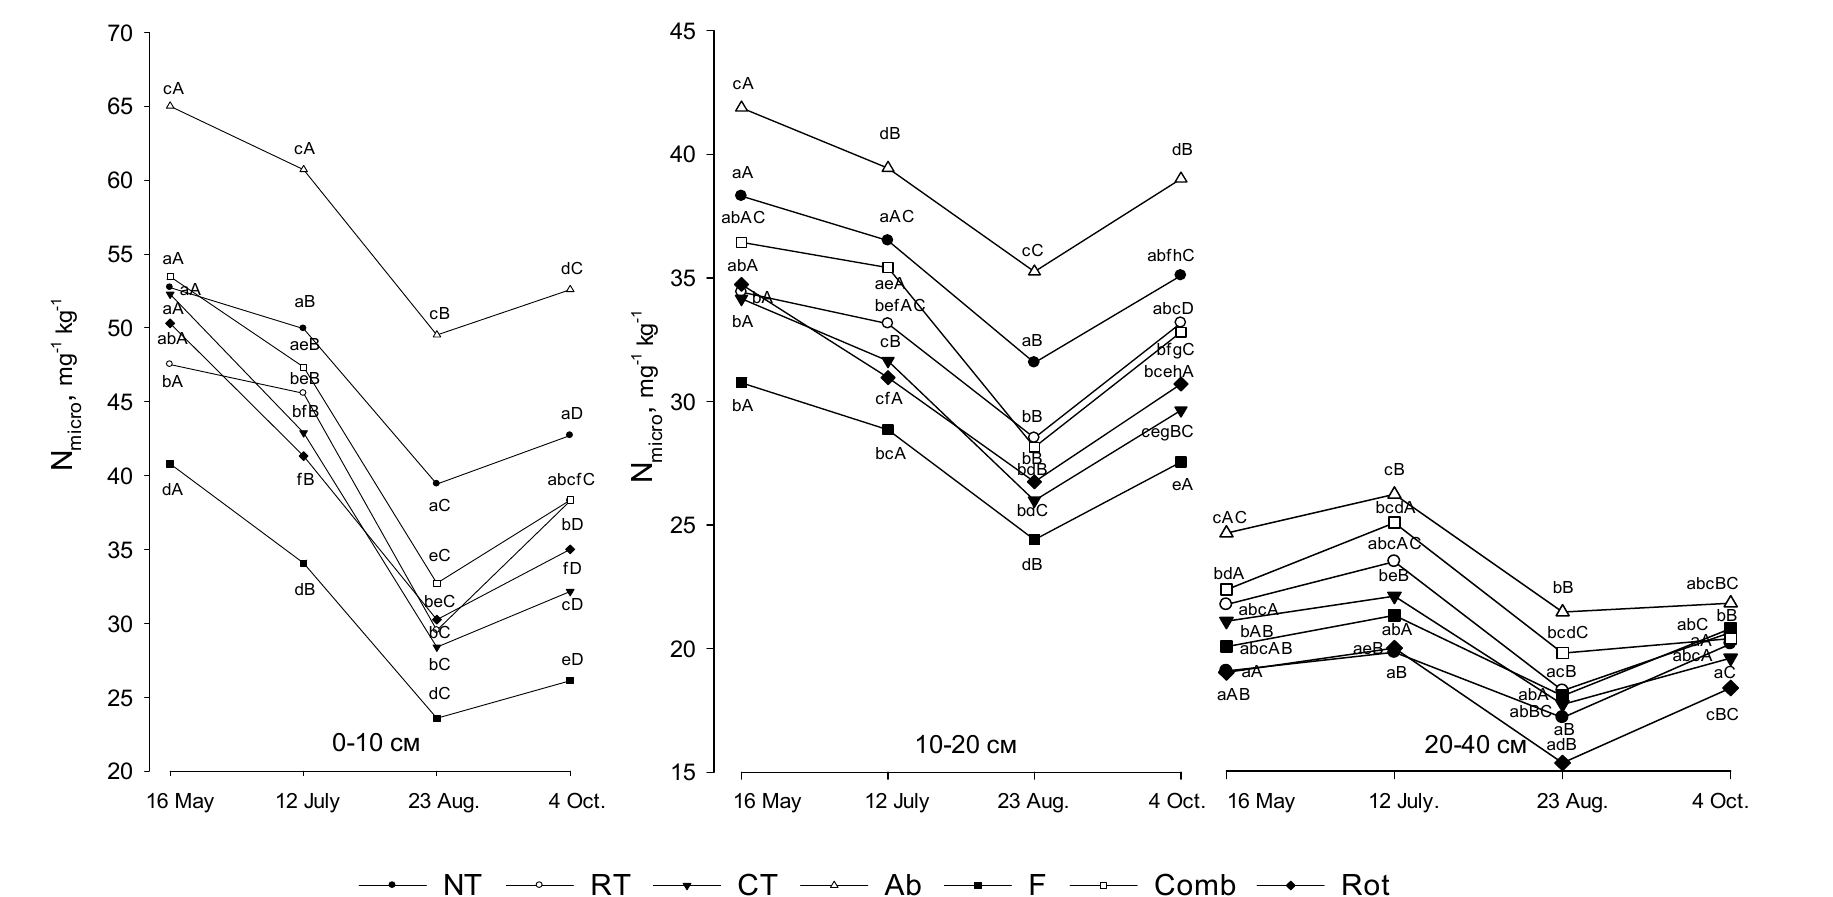
Figure 3. Seasonal dynamics of N micro in different of Mollisol layers after 9 years of use: conservation tillage (CT), no till (NT), rotary (Rot), reduced (ridge) tillage (RT), combined (Comb) tillage, fallow (F, 22 years) and abandoned field (Ab, 22 years). Average values with different lowercase letters indicate a significant difference between tillage options, and uppercase letters are a significant difference between the selection periods (HIP, α = 0.05).